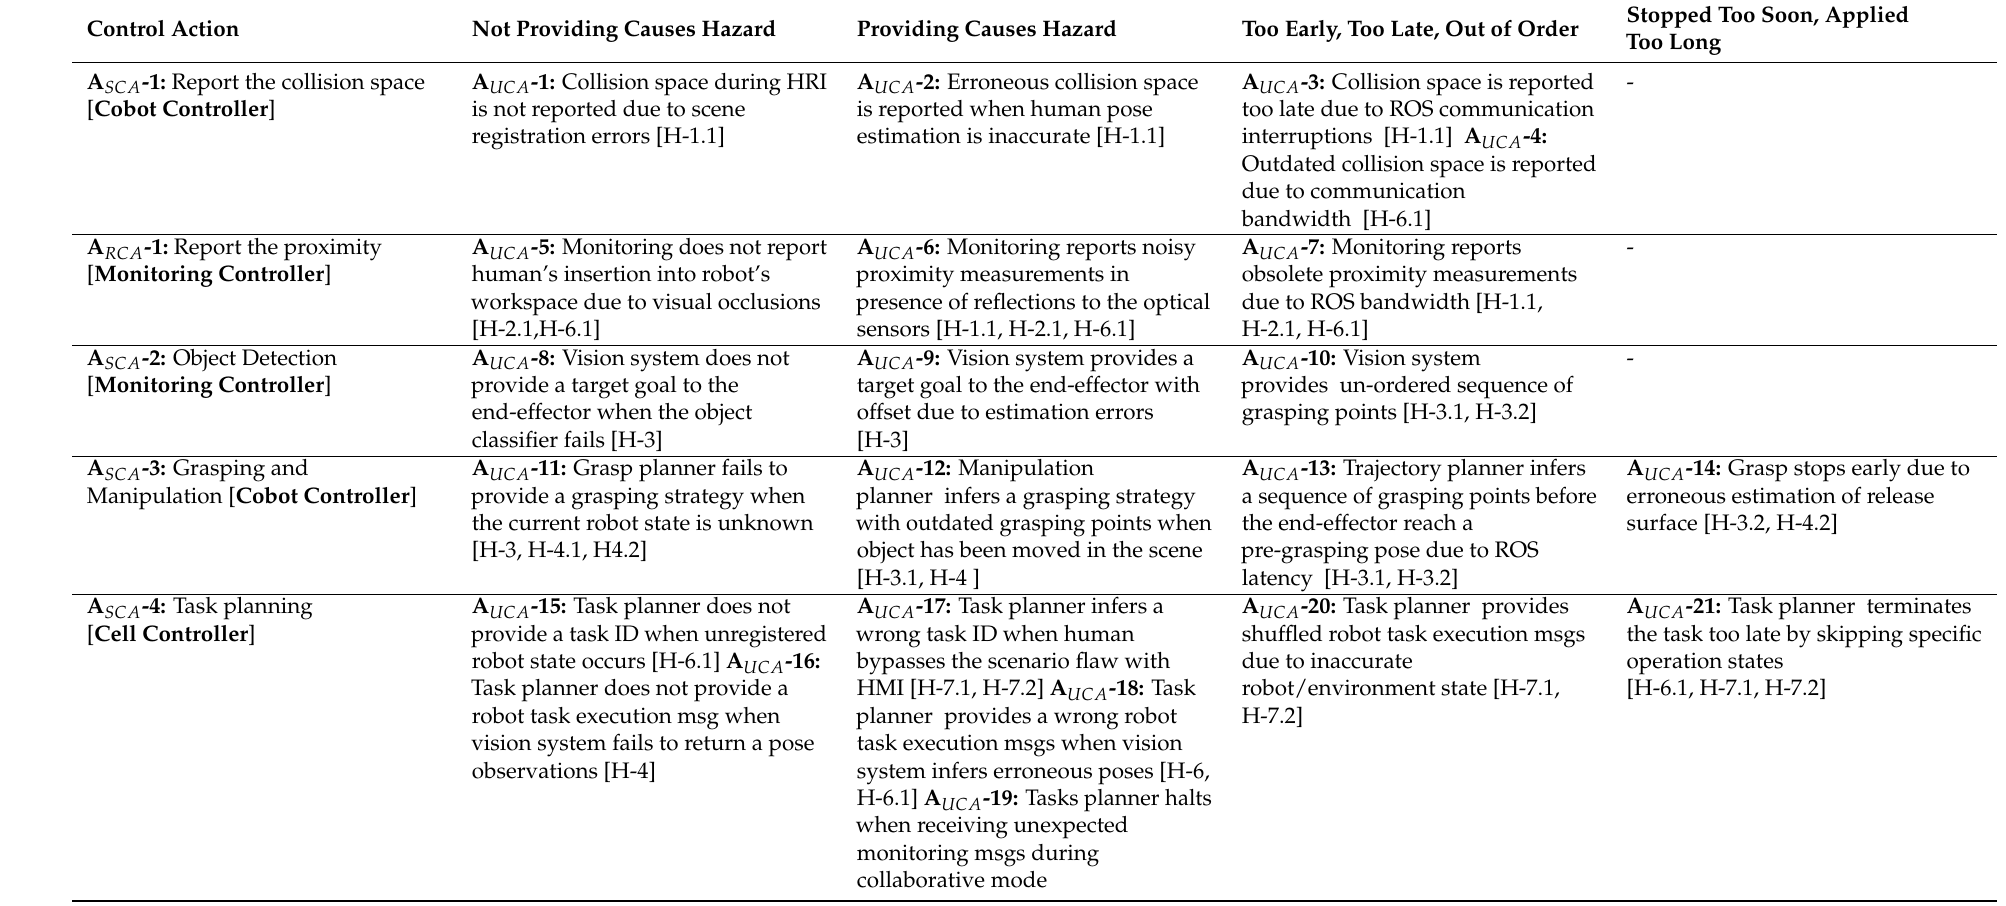
Table 2. Safe ( A SCA - ), Recover ( A RCA - ) and Unsafe ( A UCA - ) control actions for the collaborative robotic